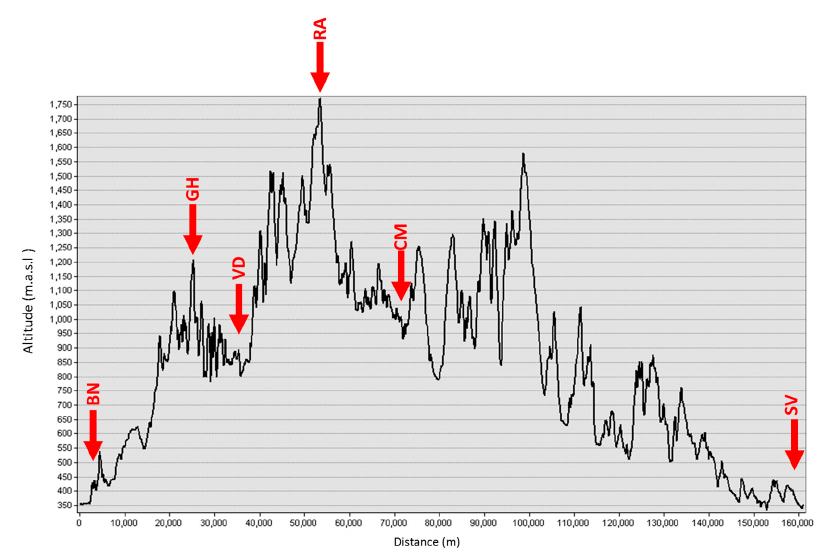
Figure 1. Site location in Europe ( top left ), in Romania ( top right ) and in the local context ( bottom ): Bistri ț a-N ă s ă ud (BN), Gura Haiti (GH), Vatra Dornei (VD), Rar ă u (RA), Câmpulung Moldovenesc (CM) and Suceava (SV). The black line represents the position of the elevation profile from Figure 2.